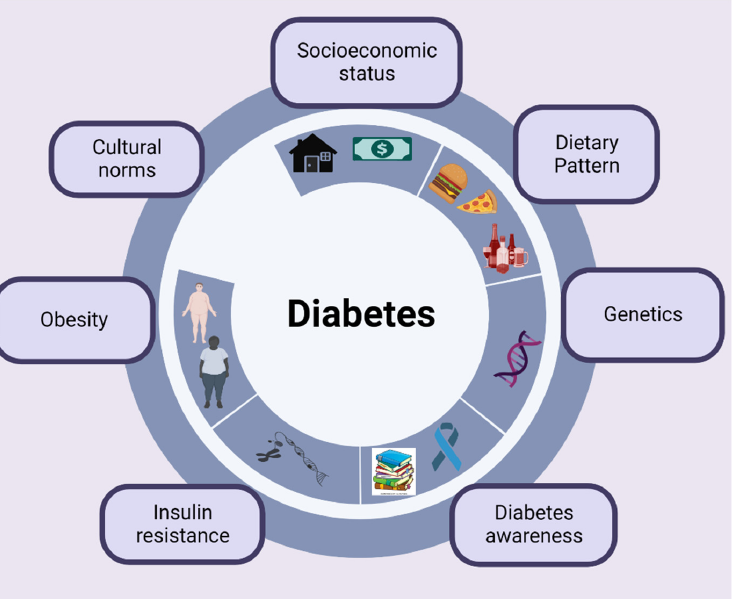
Figure 2. Factors associated with the occurrence of diabetes mellitus in Hispanics. Created with BioRender.com.